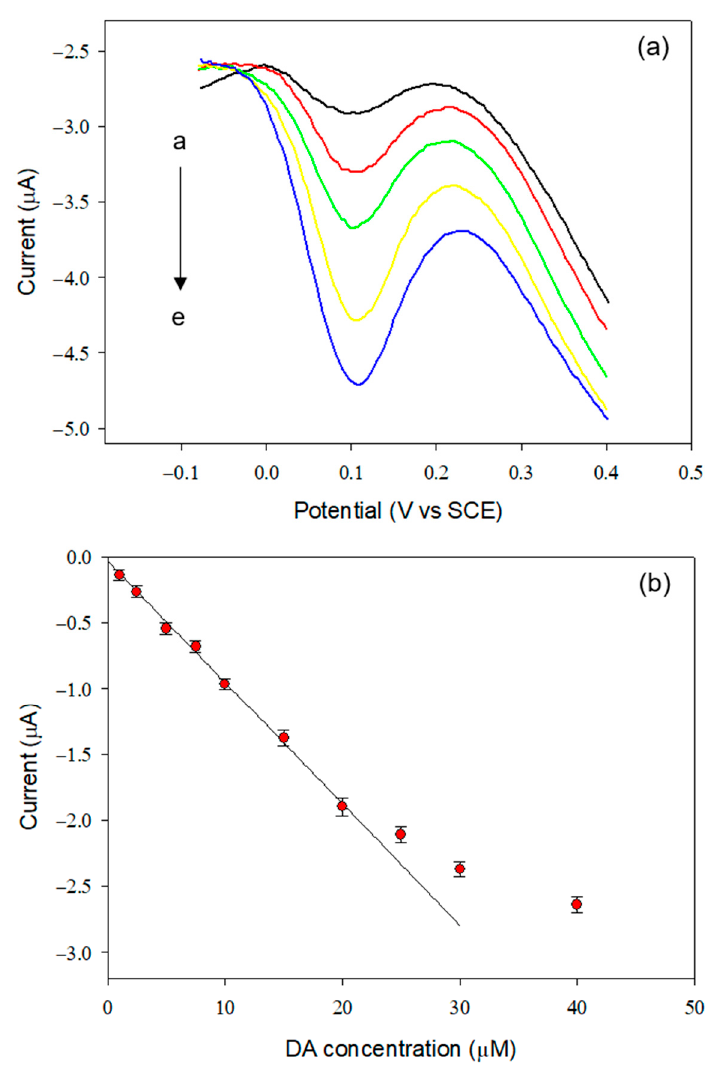
Figure 6. ( a ) DPVs of dopamine at a concentration range of 2.5–15 μ M (curves a–e) at the MIP- modified electrode. Electrolyte: phosphate buffer solution, pH 7.0 and I = 0.1 M. Potential range from − 0.1 V to +0.4 V. Potential increment: 4 mV; sampling width: 20 ms; pulse amplitude: 50 mV; pulse period: 0.2 s; pulse width: 50 ms. ( b ) Calibration curve. Each value represents the mean of triplicate measurements; the error bars represent the relevant standard deviations.